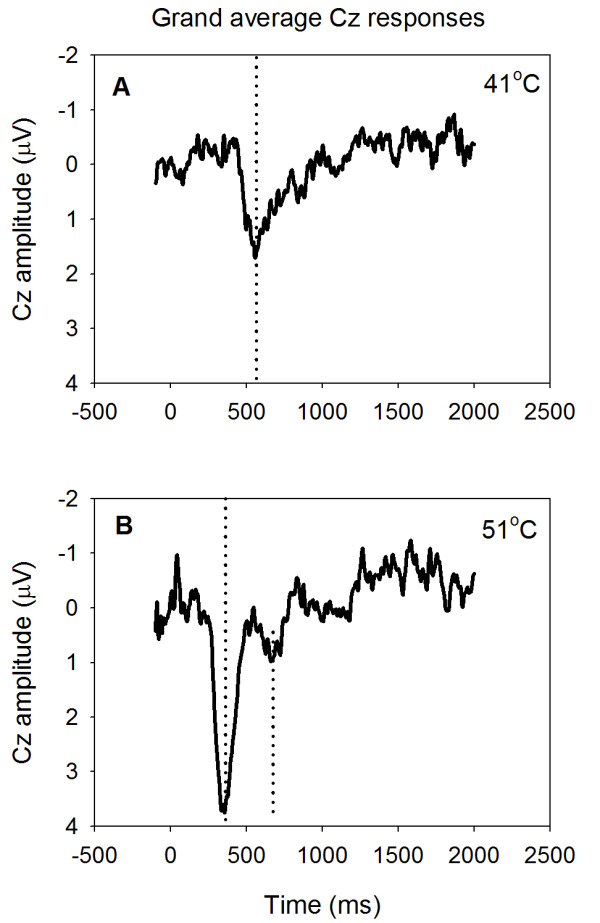
Vertex (Cz) potentials evoked by contact-heat pulses applied to the hairy skin of the left hand. Grand average responses were averaged across subjects after 10 stimuli delivered at 41°C (A) and at 51°C (B). Dotted lines mark the latencies of the major positive peaks (A and B).